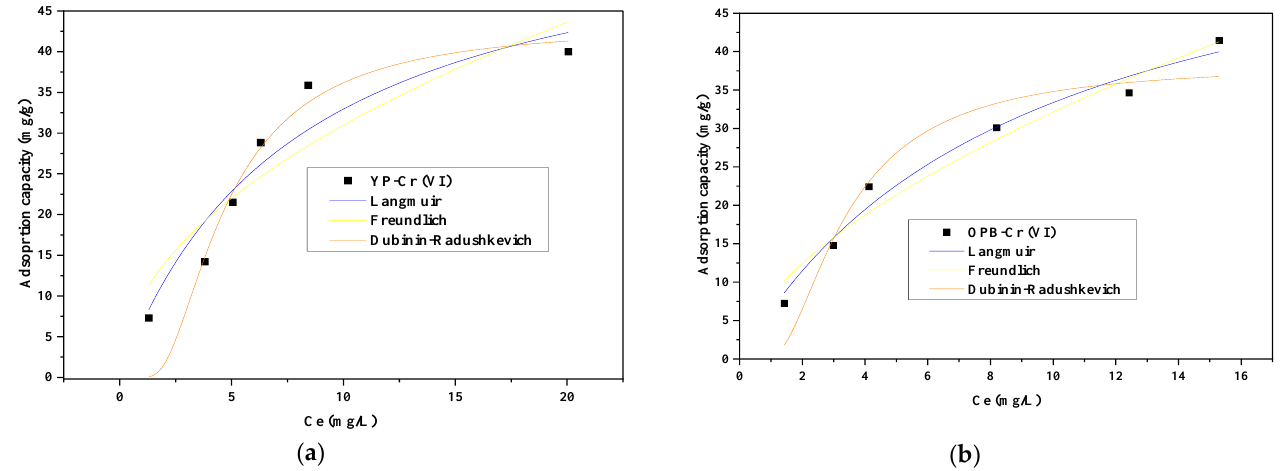
Figure 4. Modeling of hexavalent chromium adsorption isotherms over ( a ) YP and ( b ) OPB; at pH = 2, 200 rpm, 0.03 g of adsorbent dose and 55 °C. Table 6. Adjustment parameters of hexavalent chromium adsorption isotherms on YP and OPB. Non-Linear Model Parameters